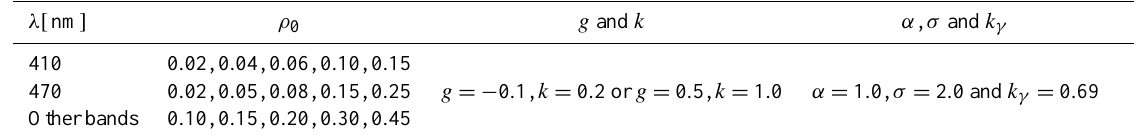
Table 3. Parameters of RPV model and the modified Fresnel model used in lookup table retrieval.